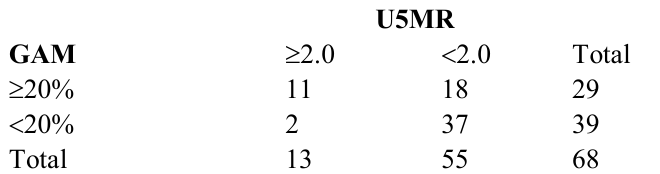
Table 4. Example of correspondence between U5MR and GAM for surveys between 1997 and